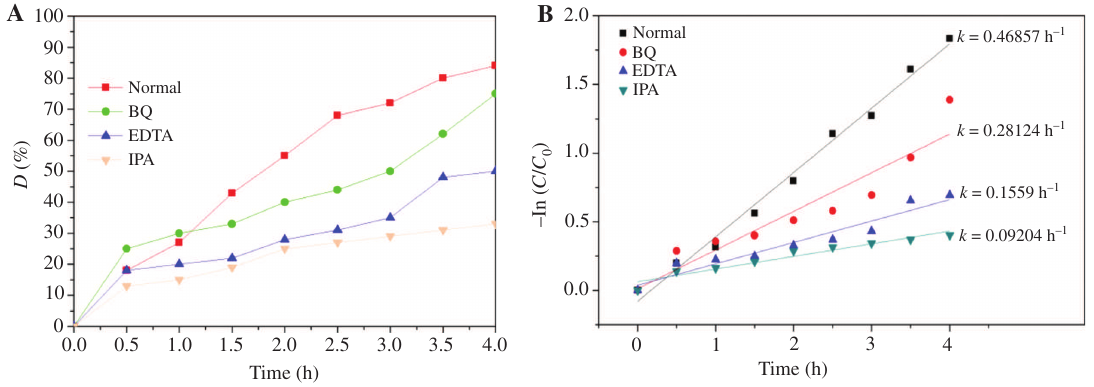
Figure 12: Map (A) and kinetic plot (B) of MO photodegradation with Cu 2 O/ZnO with the presentation of BQ, EDTA, and